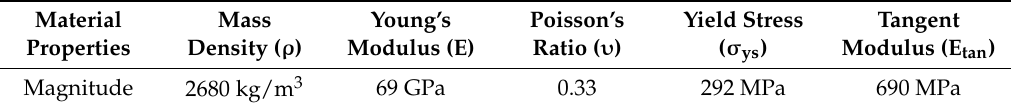
Table 2. Material properties used in the FE model of aluminum honeycombs [19].